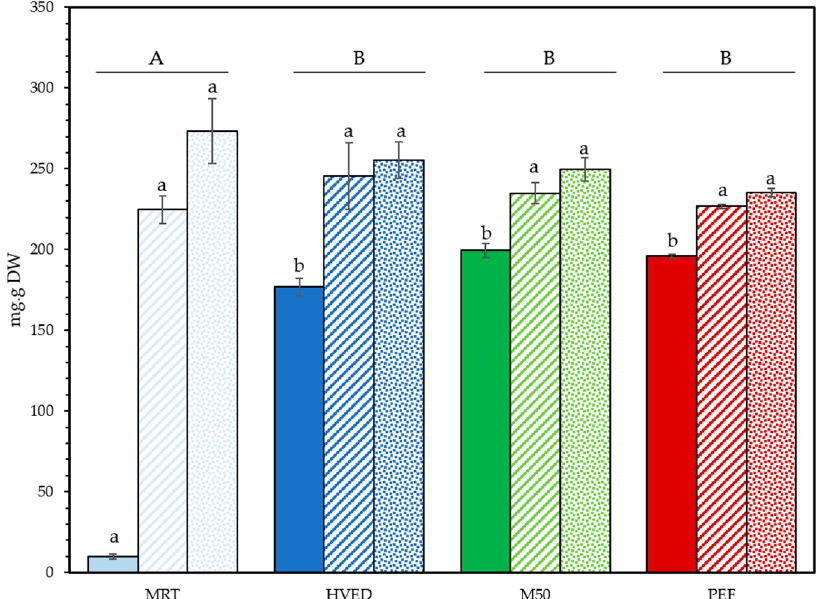
Figure 2. Final dry weight of soluble compounds extracted from GC. Complete fill: fresh GS; dashed fill: dry GS; dotted fill: powder GS. Data are shown as mean ± SD (n = 3). Upper case letters display differences between treatments (values averaged across state, n = 12). Lower case letters denote significant differences between treatments by state n = 3). Type III ANOVA with Tukey post-hoc